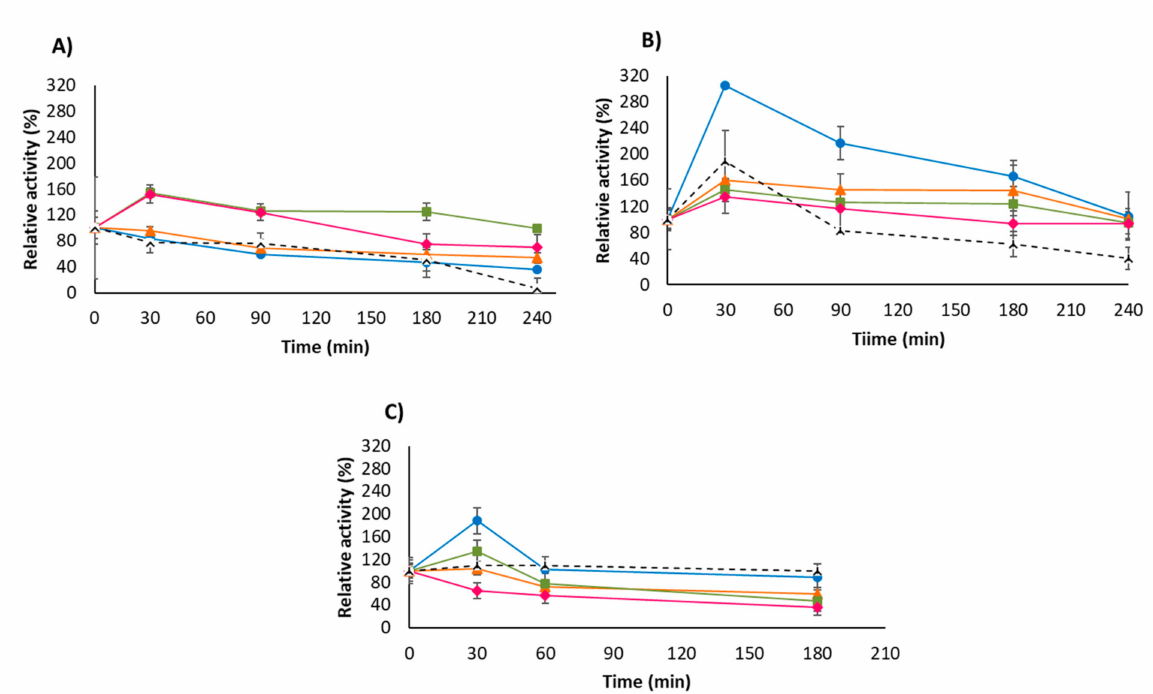
Figure 6. Stability in organic cosolvents of different lipase preparations: ( A ) ACN, ( B ) THF, and ( C ) 1,4-dioxane. Experiments were performed at 50% ( v / v ) in 50 mM Tris-HCl pH 7 and 40 ◦ C. Dotted line OC-CALB; blue circles: OC-USBA-GBX-513; orange triangles: OC-GLX-USBA-GBX-513; green squares: Q-Sepharose- USBA-GBX-513; pink rhombi: CNBr-